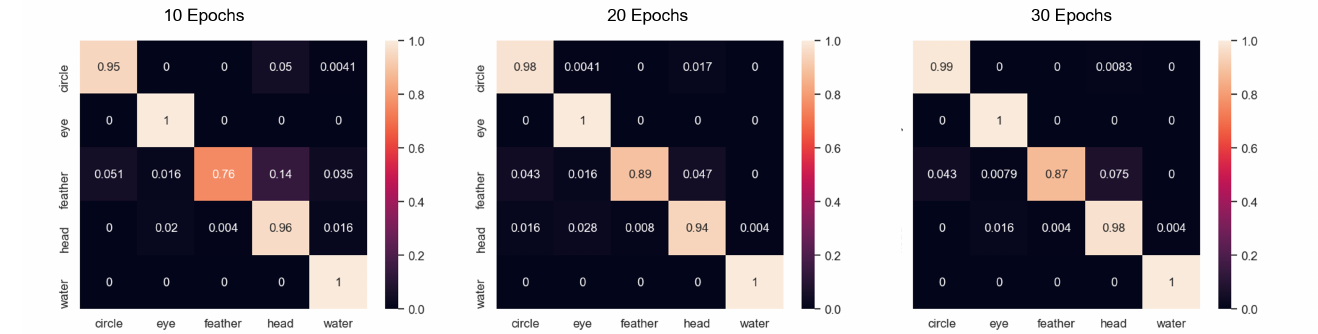
Figure 8. Left column: Classes and reference images used to create the training data for sign classification. Right Column: Random segments extracted from the reference images, which resemble decoration traces of broken fragments.